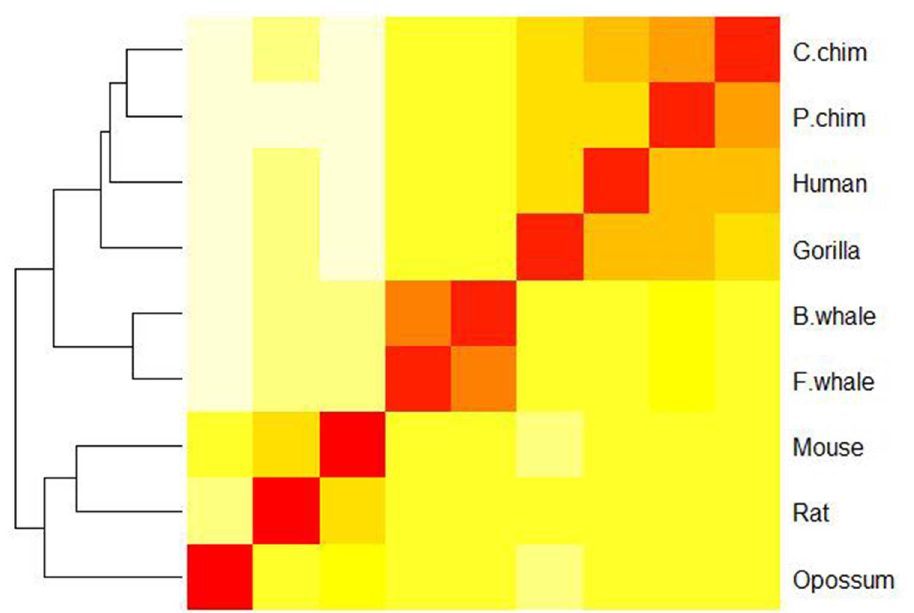
Fig 3. A heat map showing the similarity of nine species in the ND5 dataset. Red color indicatessmall distanceand high similarity betweenthe sequencesand yellow color indicateslarge distanceand low similarity, the same as below.